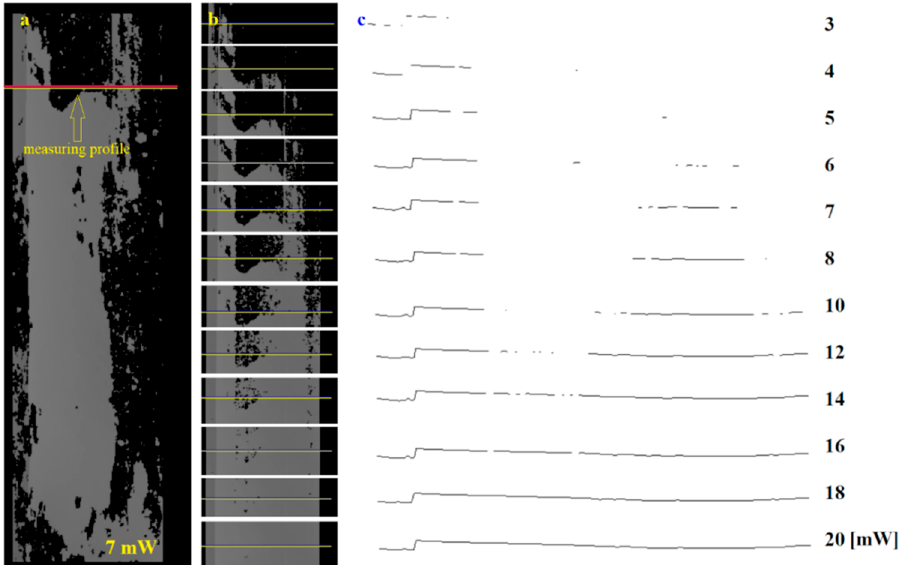
Figure 11. Analysis of the selected height profile on the board surface: ( a ) 3D image with the selected profile for surface inspection, ( b ) image fragment with selected profile recorded at different laser powers, ( c ) profile shape for power from 3 to 20 mW.